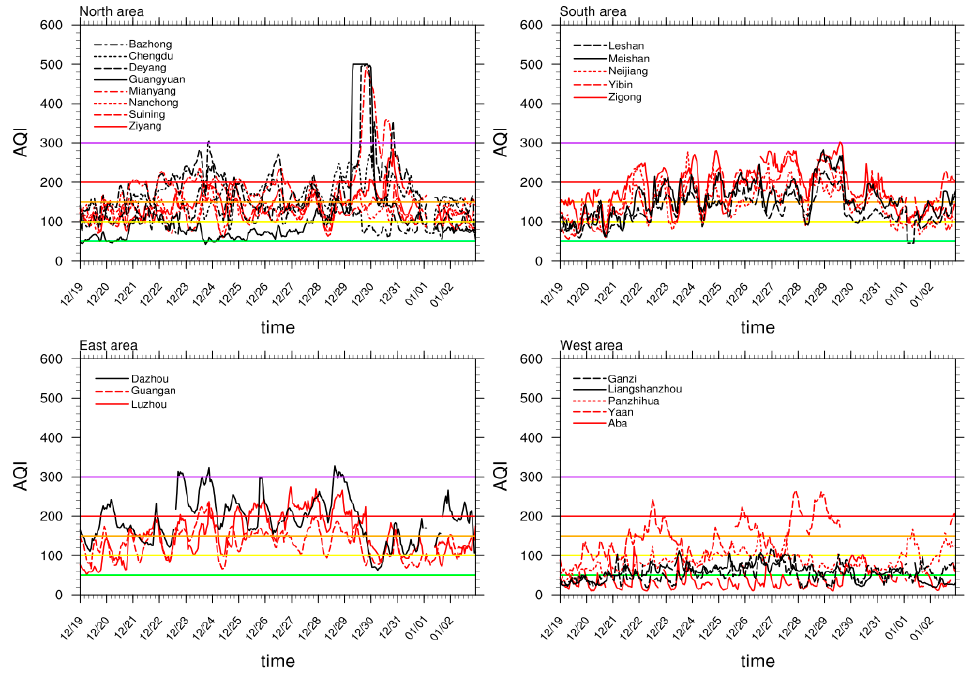
Figure 2. Hourly AQI variation in four areas from 19 December 2017 to 2 January 2018 with reference lines that denote air pollution level: very unhealthy (purple line), unhealthy (red line), unhealthy to sensitive groups (orange line), moderate (yellow line), good (green line). The corresponding AQIs are in Table